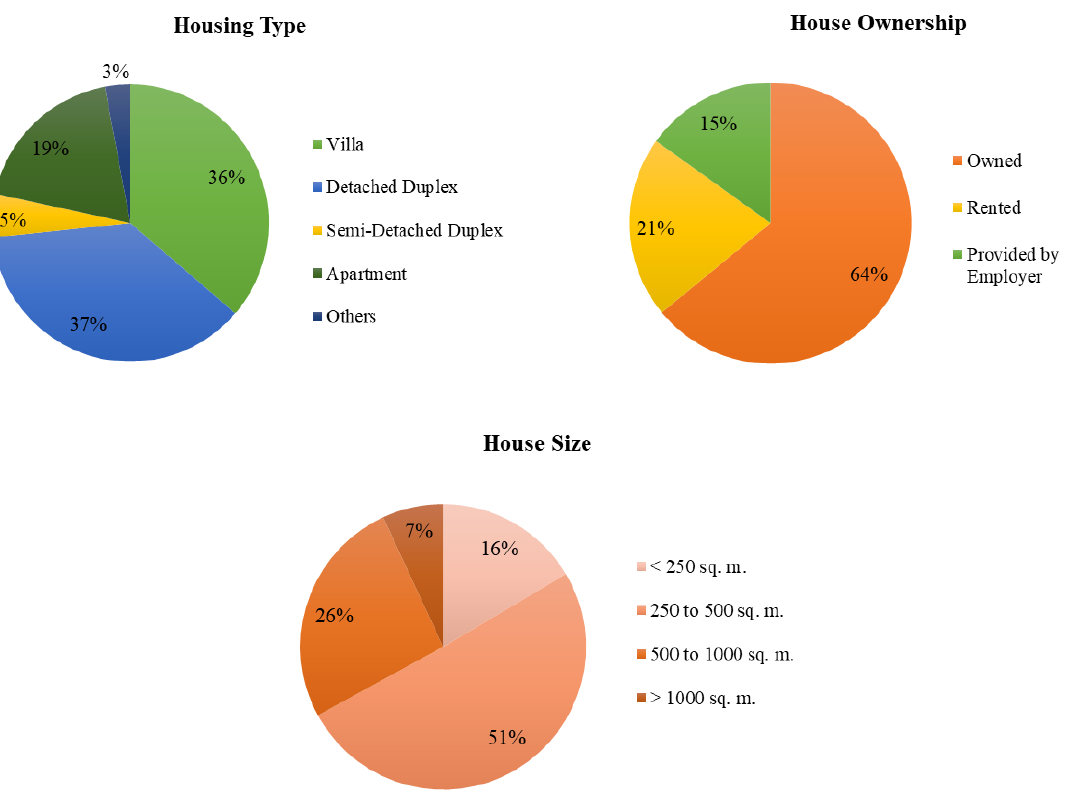
Figure 6. Existing housing stats of the respondents.